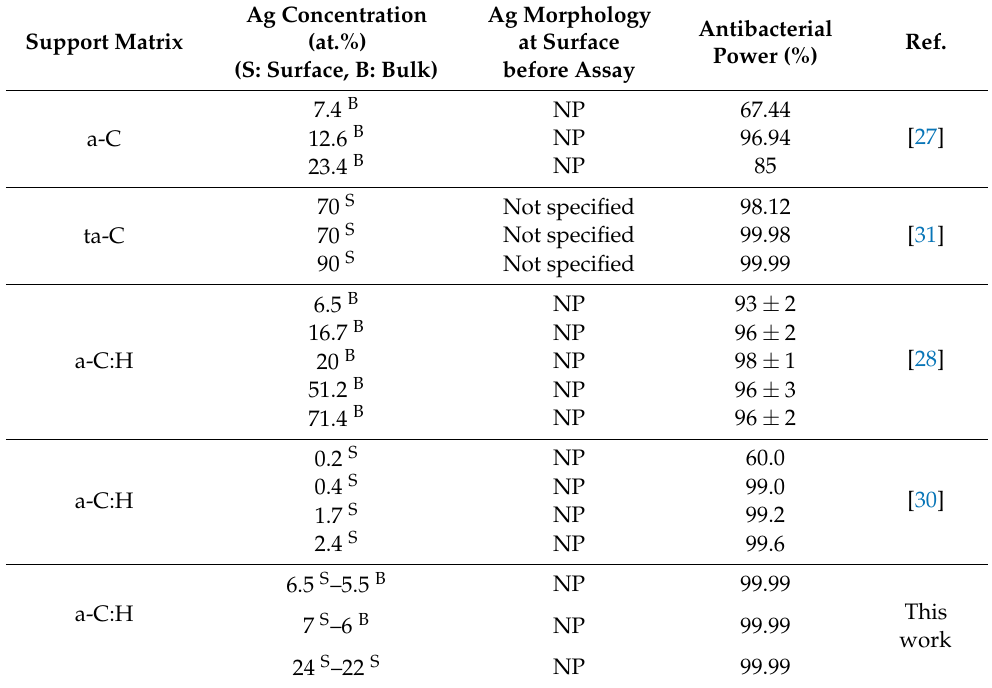
Table 2. Comparative table showing the experimental results of the antibacterial activity obtained by a CFU method for Ag-release coatings against E. coli strains. The antibacterial activity is expressed in % as seen in the section “Materials and methods”. A value of 100% means that the antibacterial activity is total: not one colony is counted after seeding. a-C = amorphous carbon; ta-C = tetragonal amorphous carbon; a-C:H = hydrogenated amorphous carbon. NP = nanoparticles. Ag Concentration Ag Morphology Antibacterial Support Matrix (at.%) at Surface Power (%) (S: Surface, B: Bulk) before Assay